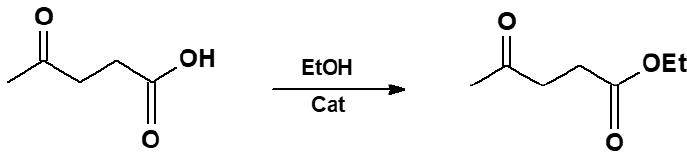
Figure 7. Esterification of levulinic acid with EtOH over UiO-66(Zr) and NH 2 -UiO-66(Zr) catalytic materials.